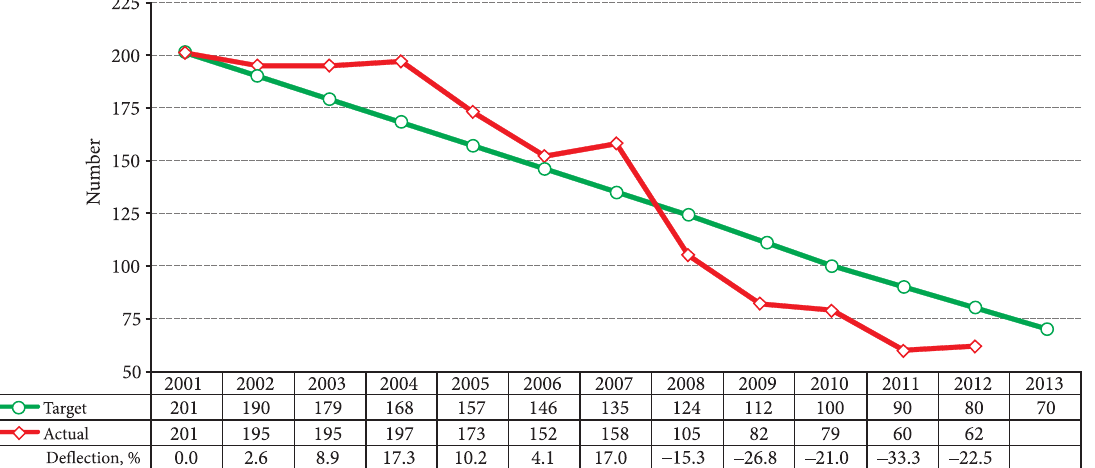
Fig. 9. Number of vulnerable road users killed and the target for 2001–2012